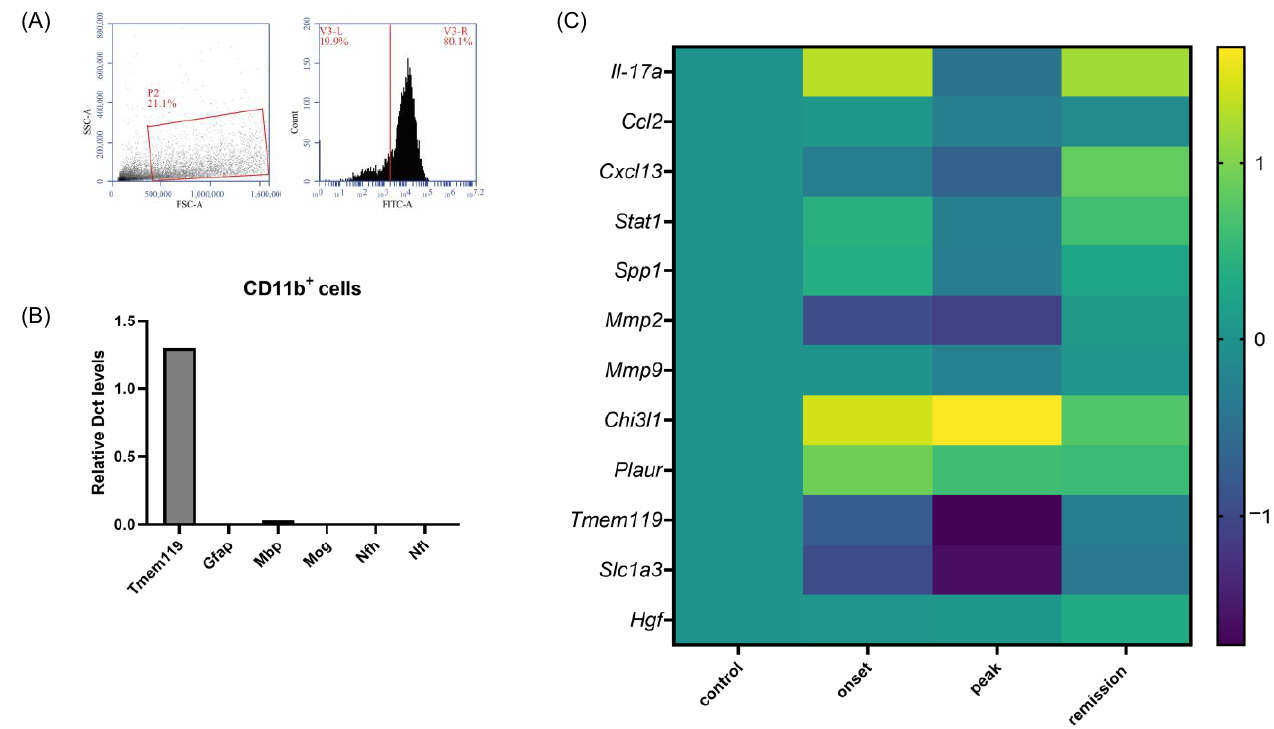
Figure 10. Validation of purity and differential expression in CD11b + sorted cells during the different phases of PLP-induced EAE. ( A ) Flow cytometry analysis validating the purity of the obtained CD11b cell population. ( B ) The levels of mRNA transcripts for the selected genes representative of other CNS cells were measured in CD11b + cell samples isolated from naive and EAE mice on the onset, peak, and remission phases by RT-qPCR. ( C ) The levels of mRNA transcripts for the selected genes relative to Gapdh were measured in CD11b + cell samples isolated from naive and EAE mice on the onset, peak, and remission phases by RT-qPCR. A total of 2–3 mice were used in the experiment (logarithmic scale).